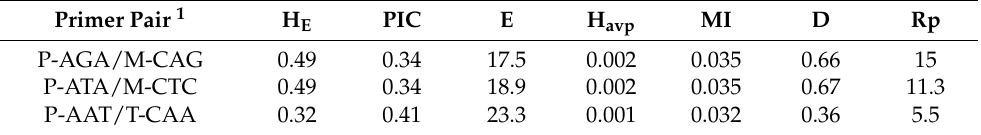
Table 2. carrot genotypes.